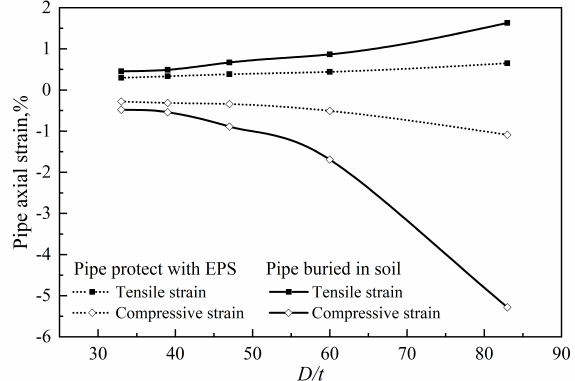
Fig. 6. Max tensile and compressive strain of buried pipe with different D / t .